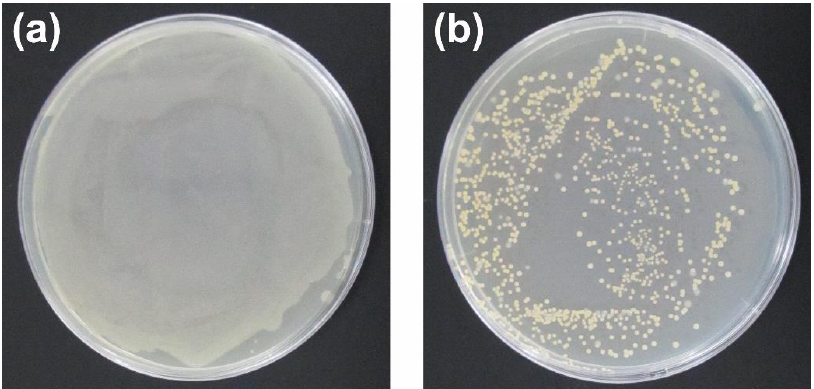
Figure 11. A comparison of the bacterial colony numbers that were treated by the AgNO 3 /SS/agar film ( a ) and the AgNPs/SS/ agar film ( b